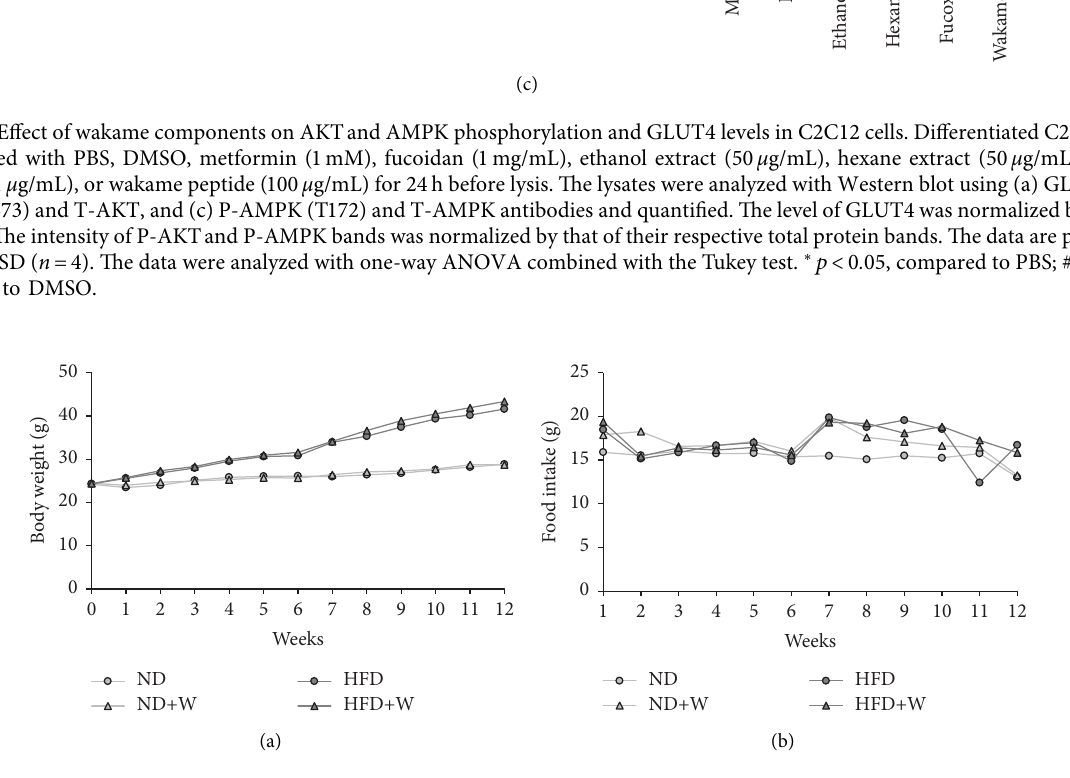
Figure 3: Te efect of wakame on body weight and food consumption. Seven-week-old C57BL/6J mice were reared on experimental diets for 3 months and measured for body weight and food consumption weekly. (a) Te change in body weight over 3 months. (b) Te weekly food consumption over 3